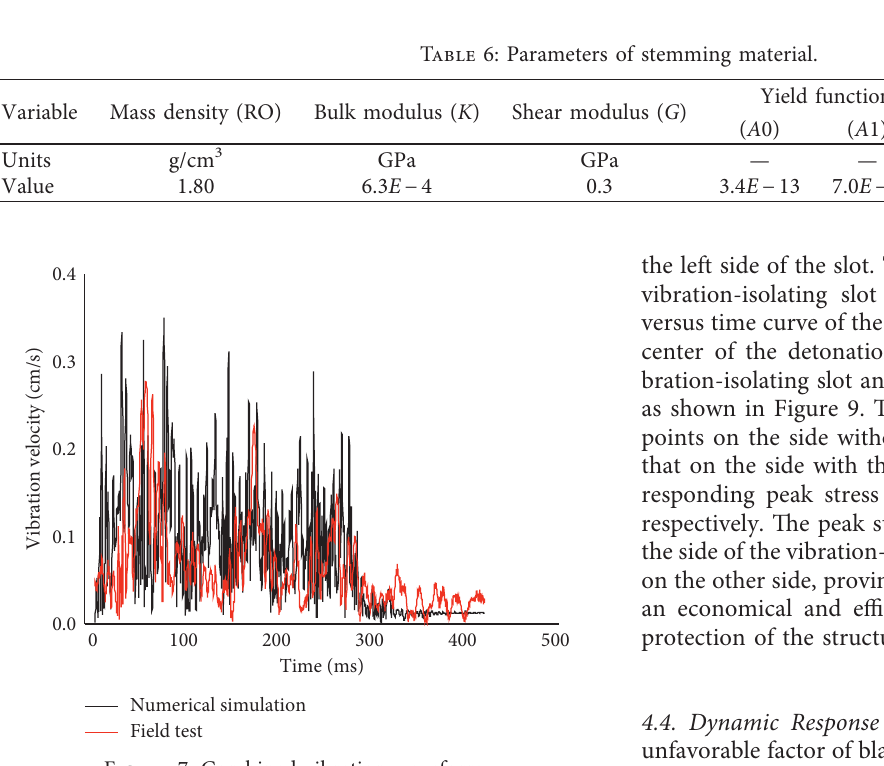
Figure 7: Combined vibration waveform.